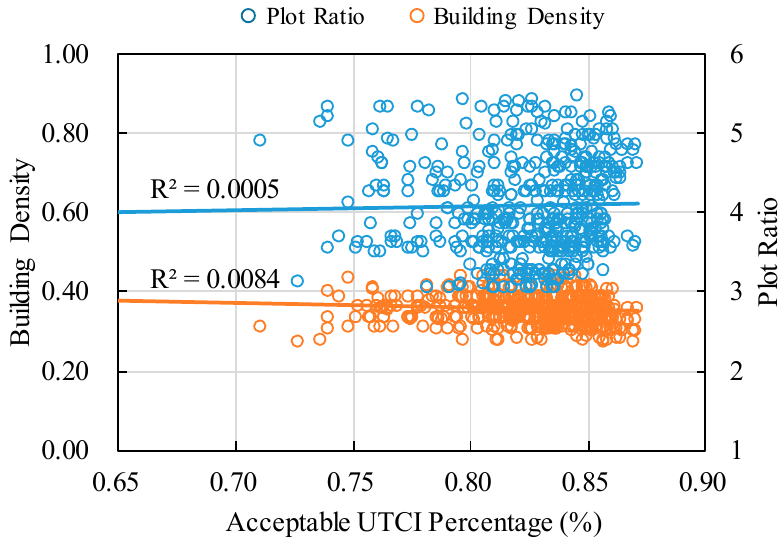
Figure 8. Correlation results of building density, plot ratio, and acceptable UTCI percentage at block level.